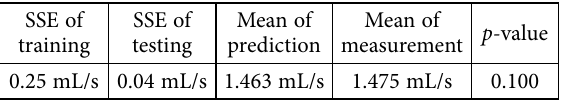
Table 6. Results of hold-out validation